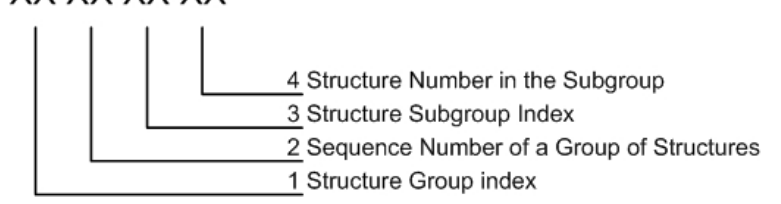
Figure 8. Ship structure classification.